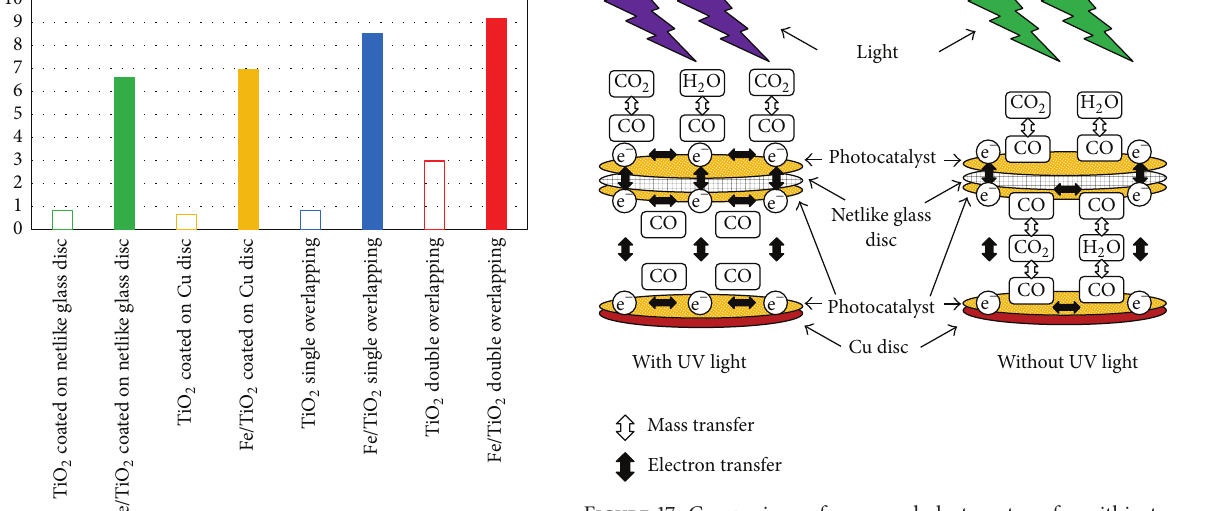
Figure 17: Comparison of mass and electron transfer within two overlapped photocatalysts between the illumination condition with UV light and that without UV